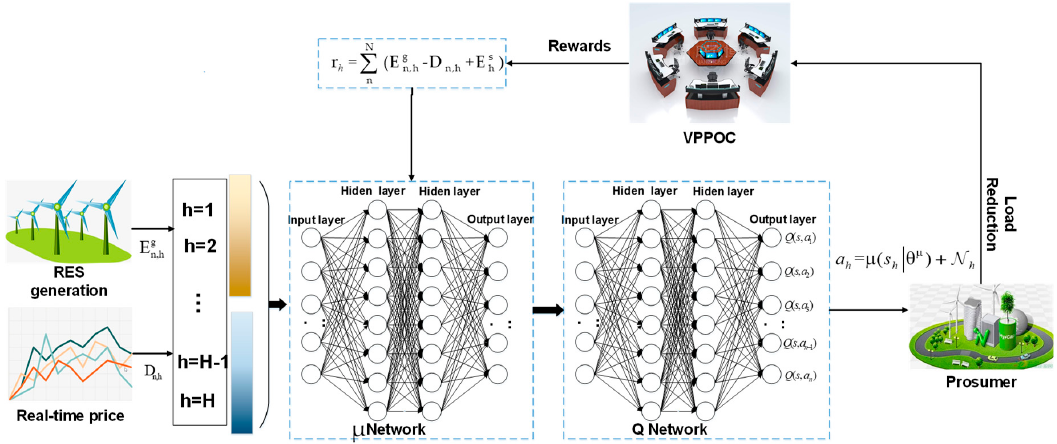
Figure 3. The overall diagram of the proposed decision-making process with deep deterministic policy gradient (DDPG) algorithm.